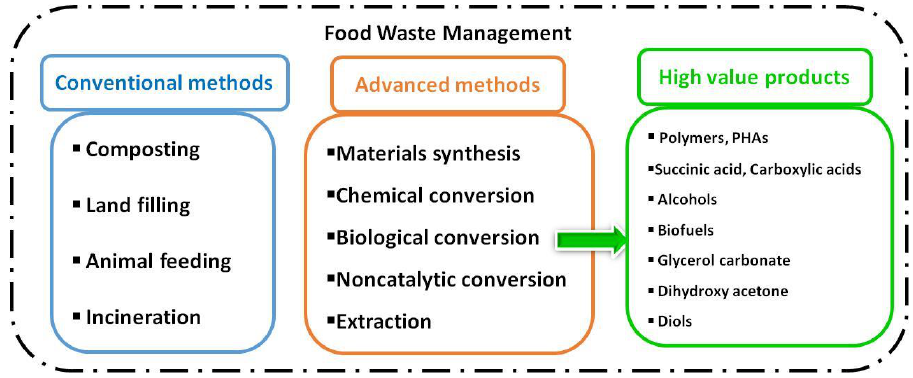
Figure 3. Technical valorization of food wastes for the preparation of high value products.